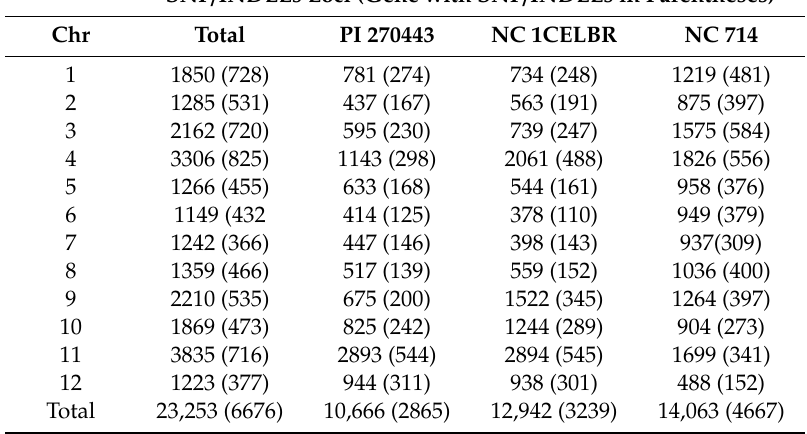
Table 5. Distribution of single nucleotide polymorphisms (SNP) / insertion–deletions (INDELs) on di ff erent chromosomes of